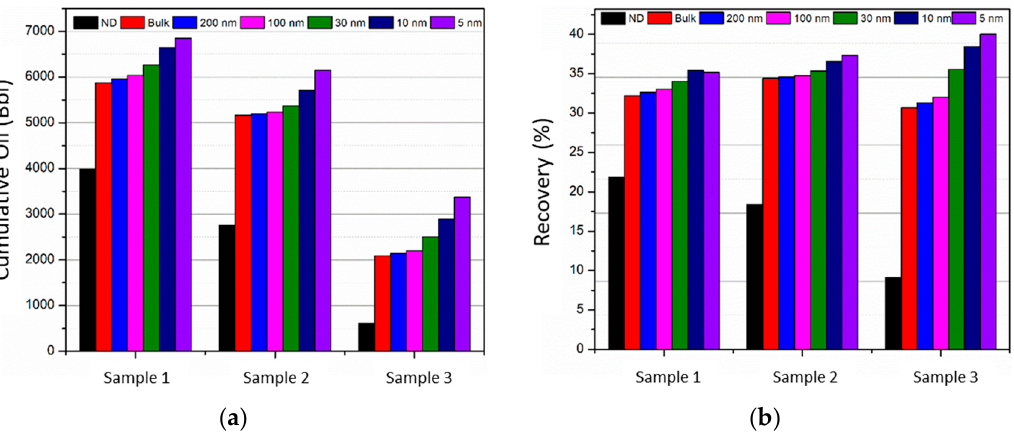
Figure 15. ( a ) Cumulative oil (bbl) and ( b ) recovery (%) for different pore